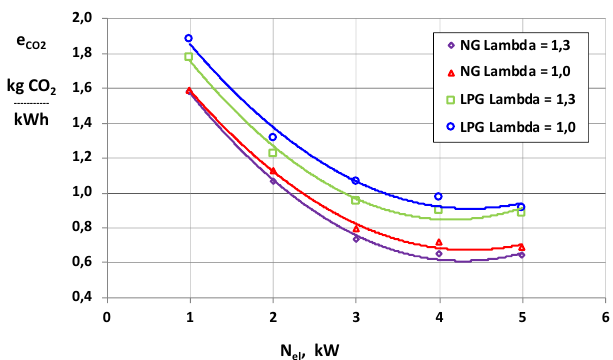
Fig. 8. Specific emission of CO2 vs mCHP unit output electric power